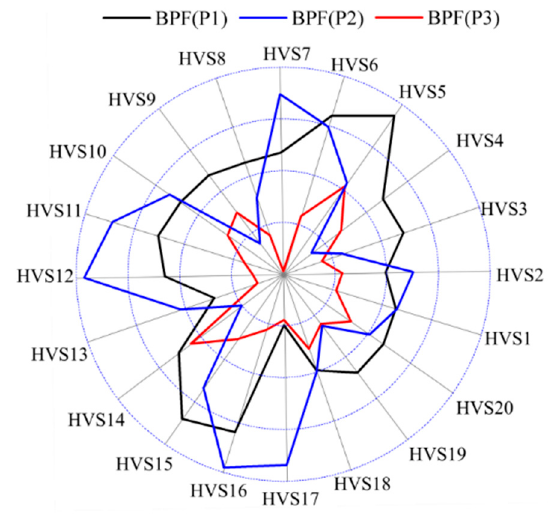
Figure 17. Distribution of pressure fluctuations of components of BPF at different circumferential positions at P1, P2, and P3 operating points. Table 5. Shift angle of peak value when the mass flow rate decreased.